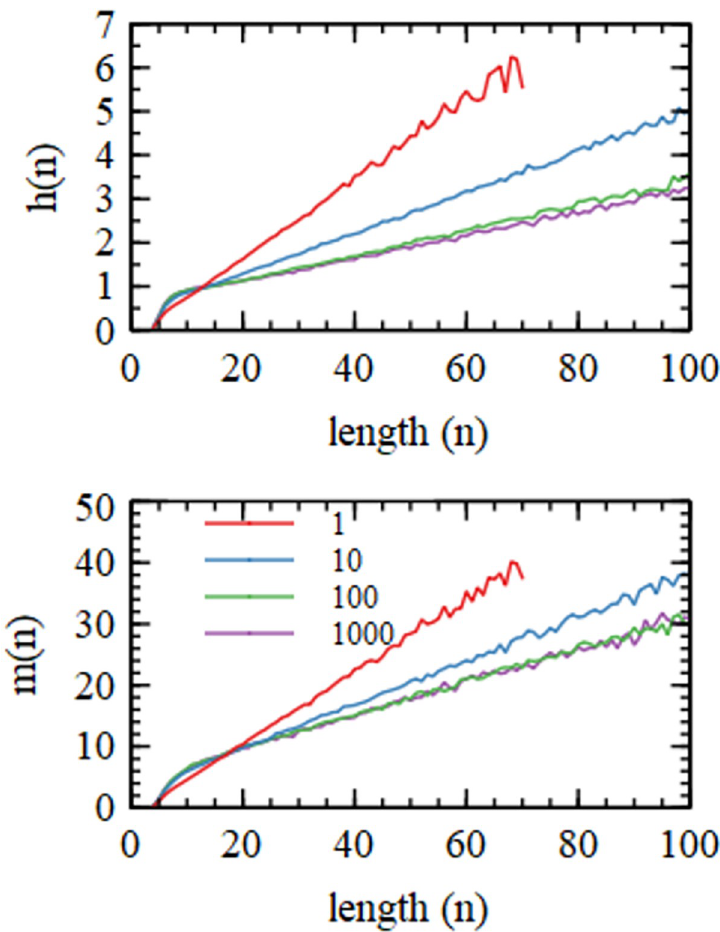
Fig 5. Mean number of helices, h ( n ), and mean number of paired bases, m ( n ), as a function of total sequence length n for four simulations with varying values of the monomer addition rate k add .